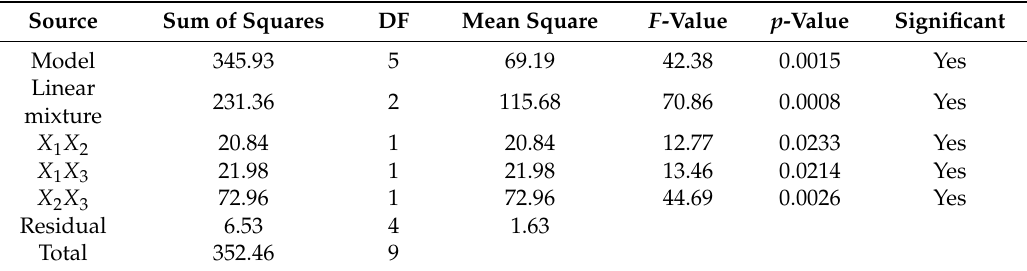
Table 10. ANOVA results for modulus of immediate elasticity Burgers model ( E 1 ).